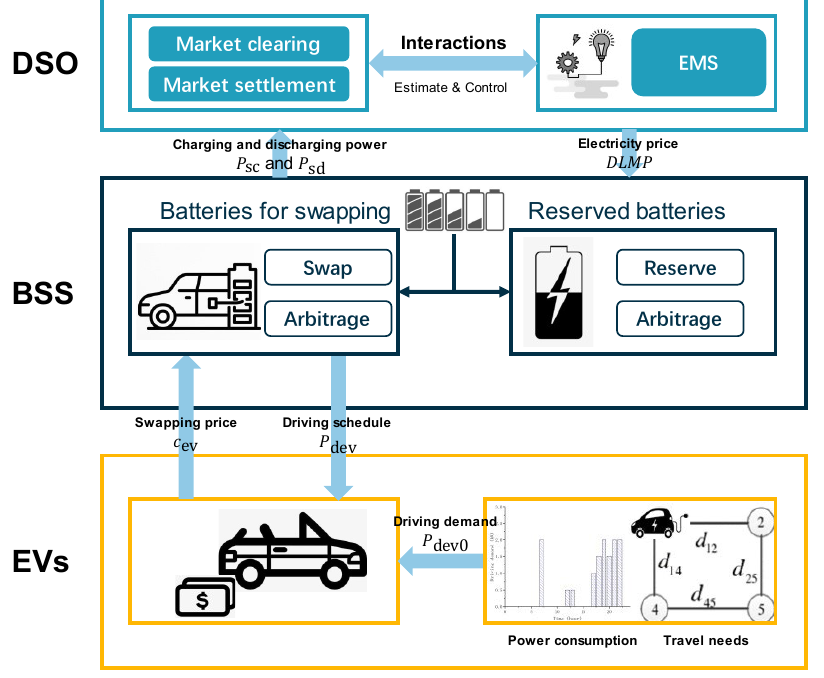
Figure 1. Operation mode of battery swapping station (BSS) .